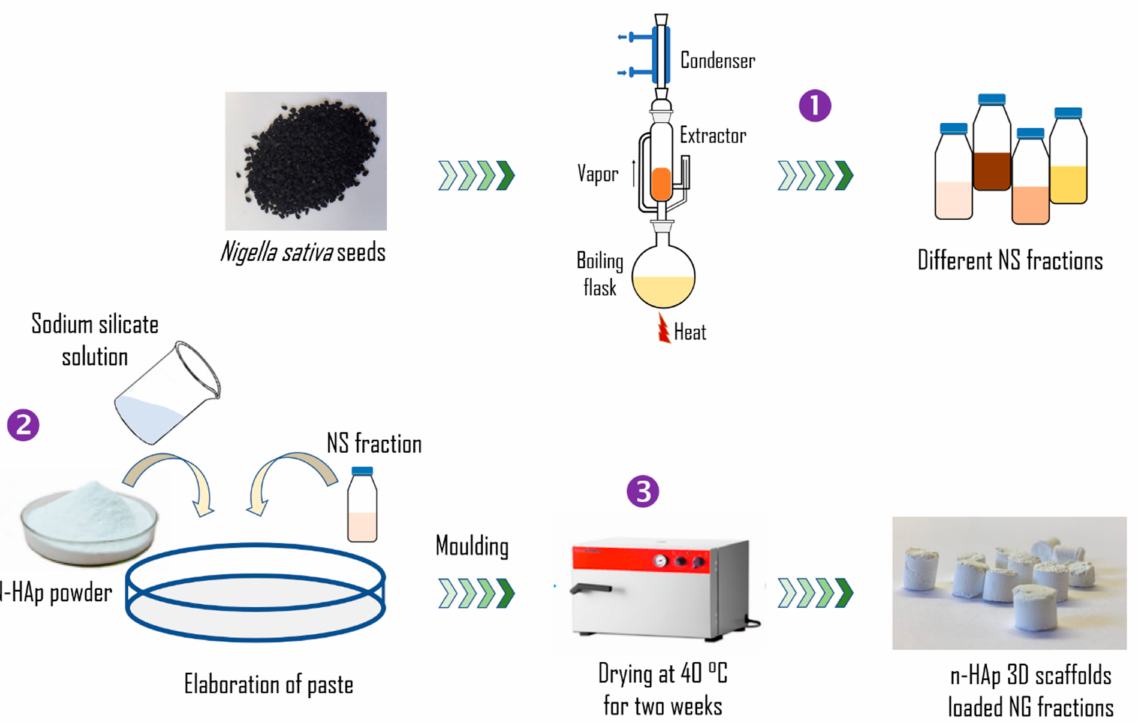
Figure 1. Schematic representation of the NS extraction method and 3D n-HAp-based composite scaffold fabrication. (1) extraction, (2) scaffolds preparation and (3)